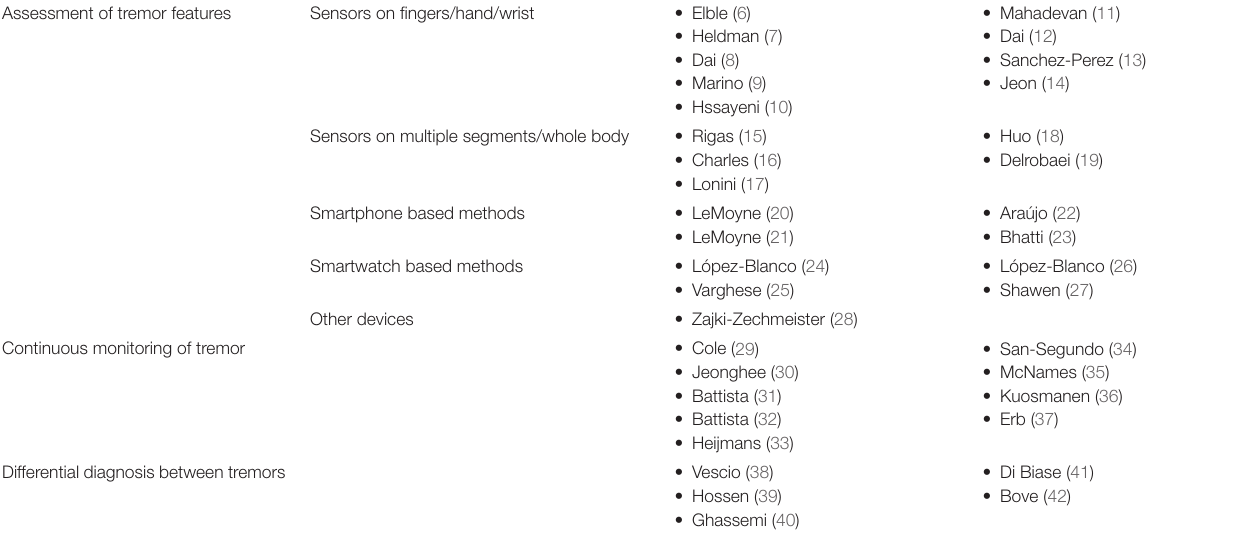
TABLE 1 | Classification of examined